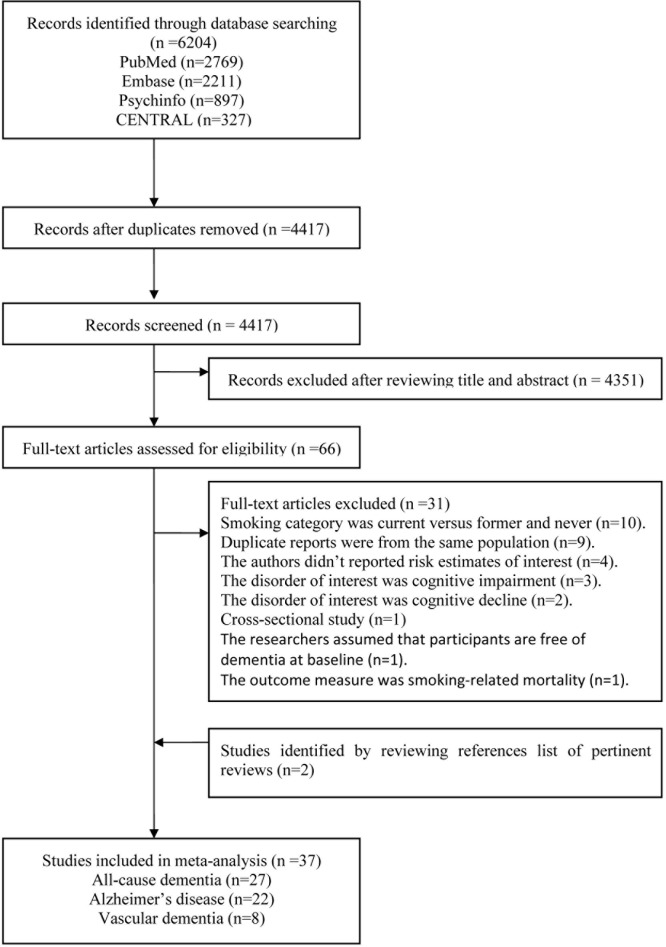
The flowchart of identifying relevant studies.